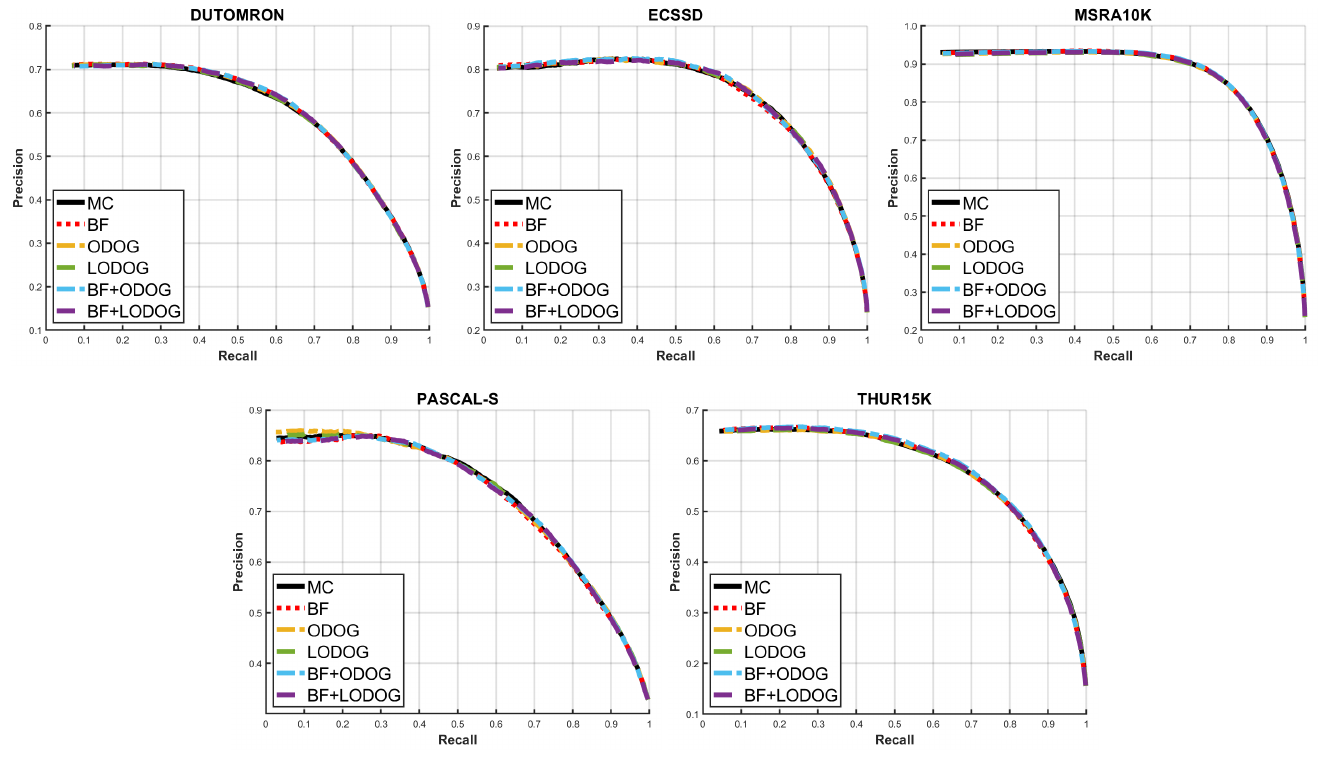
Figure 10. PR curve of